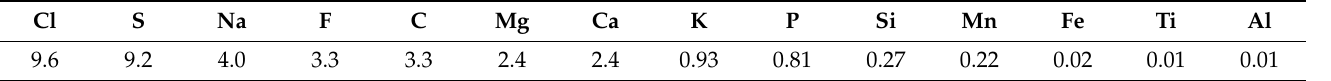
Table 7. Coefficients of water migration of chemical elements in the Critical Zone taking into account the contribution of cyclic sea salts and anthropogenic substances [37].